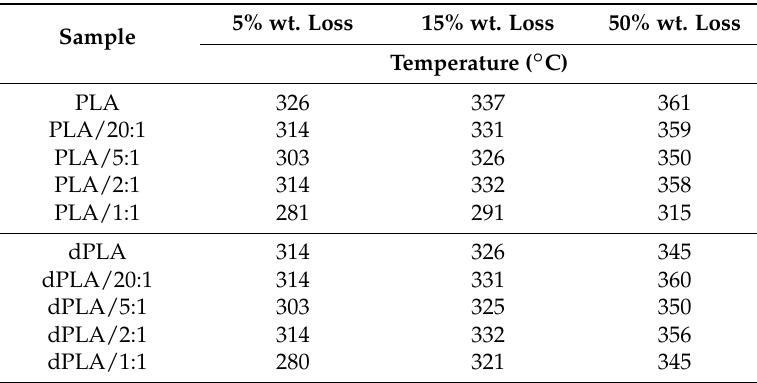
Table 3. Tabulated thermal analyses values of tested films.